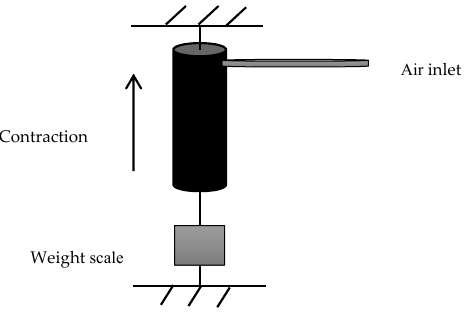
Figure 6. The pulling force of the contractor PMA.